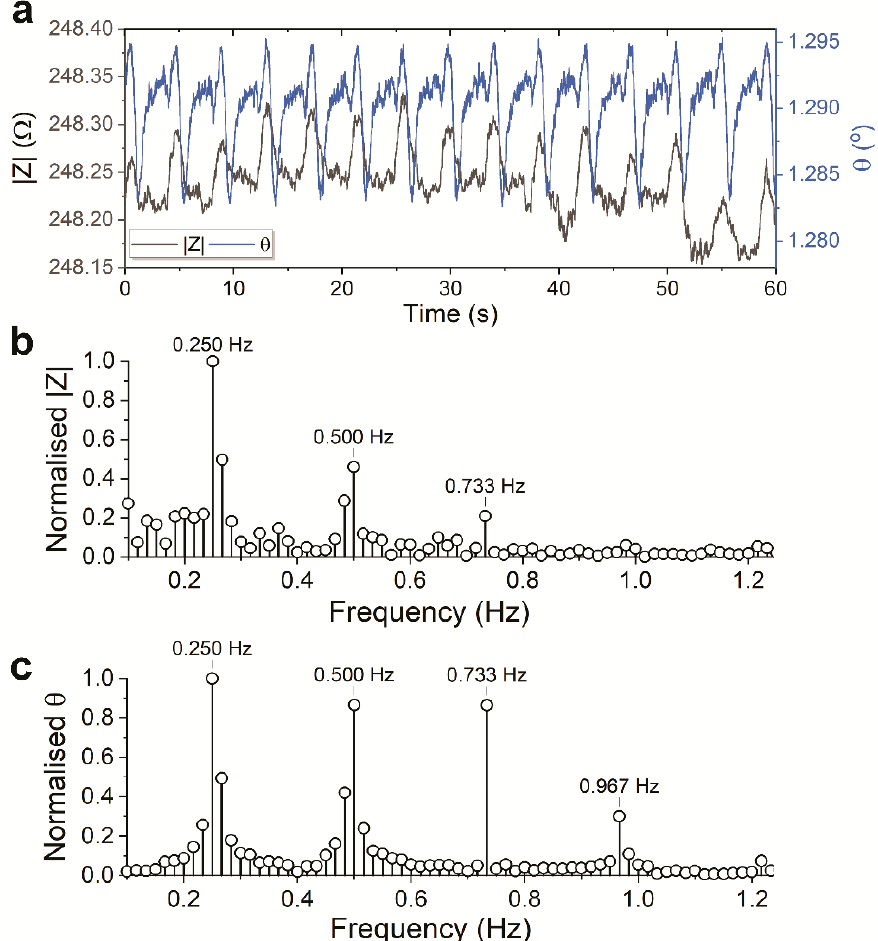
Figure 7. ( a ) Overlaid impedance magnitude and phase of beating hPSC-CMs recorded between RuOx and Pt wire electrodes in the Teflon chip holder setup. ( b ) Frequency components of the magnitude and ( c ) the phase data.